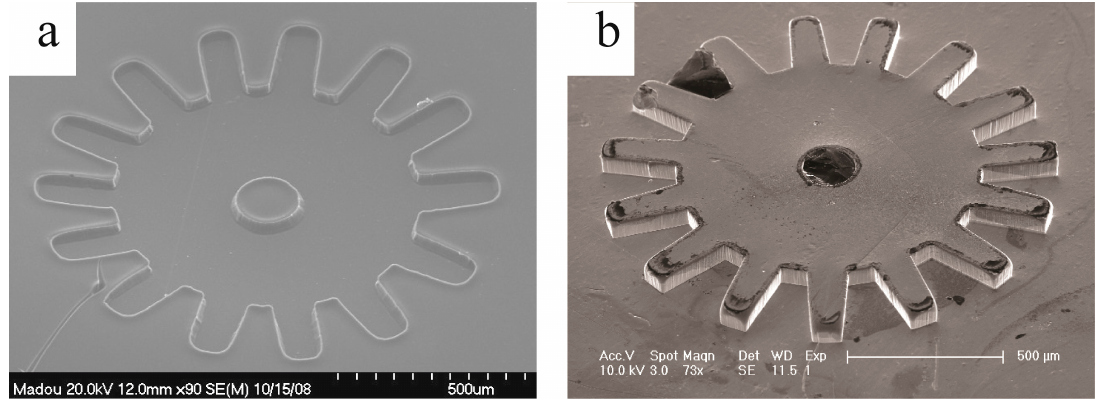
Figure 5. Molding of a bulk metallic glass gear ( b ) using the glass-like carbon micromold shown in ( a ). Black portions in ( b ) are carbon residues from the de-molding